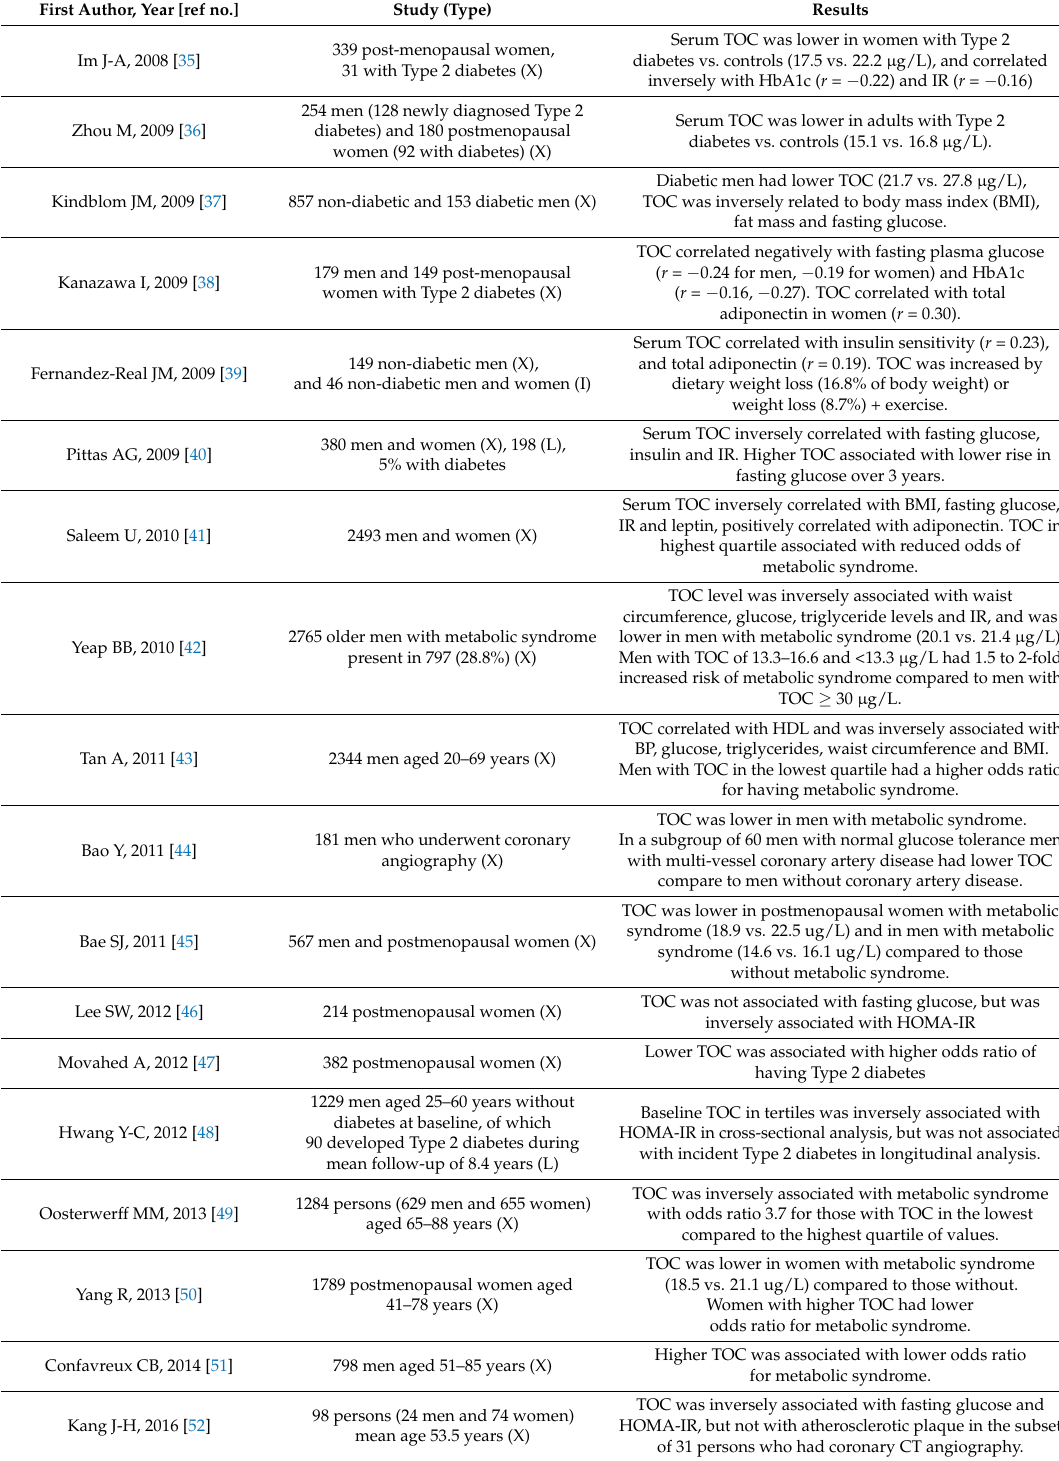
Table 1. Selected studies examining associations of total circulating osteocalcin (TOC) with insulin resistance, metabolic syndrome and diabetes in men and women are summarised. X = cross-sectional analysis, L = longitudinal analysis, I = interventional component, HOMA = homeostasis model assessment, HOMA-B = β -cell activity, HOMA-IR = insulin